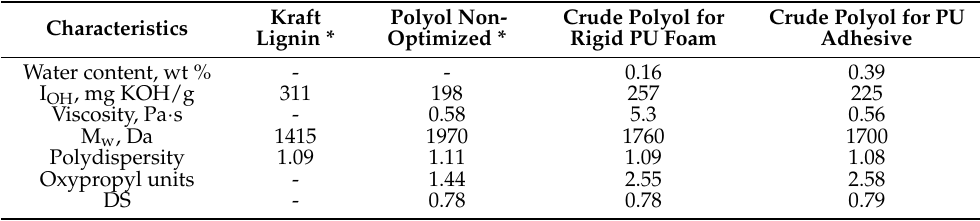
Table 5. Chemical and physical characteristics of lignin and lignin-based polyols.